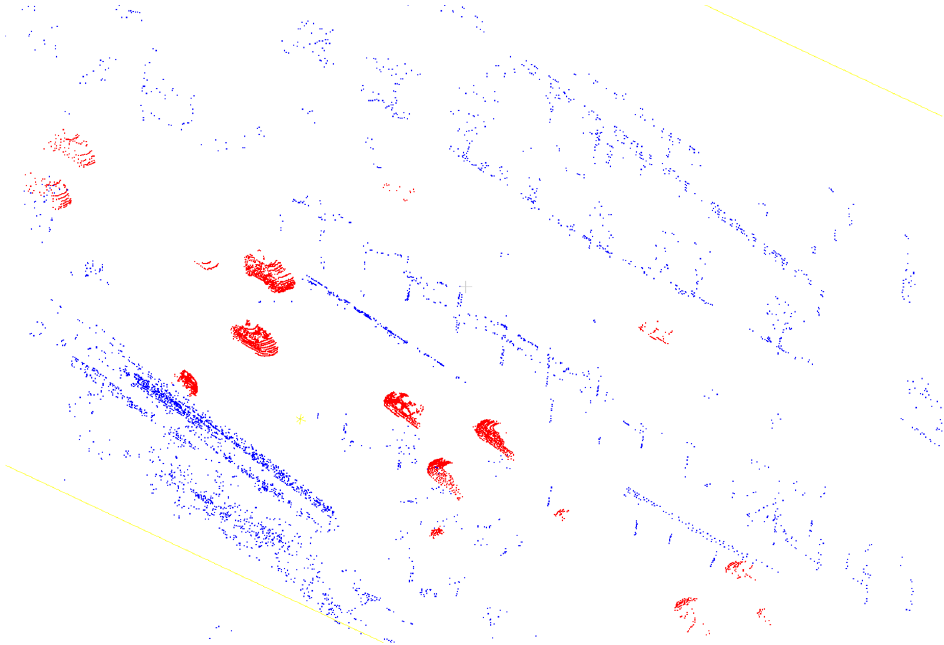
Figure 12. Foreground and background point ‐ cloud data in a frame. Table 2. The numbers of frames and annotations in two scenes.